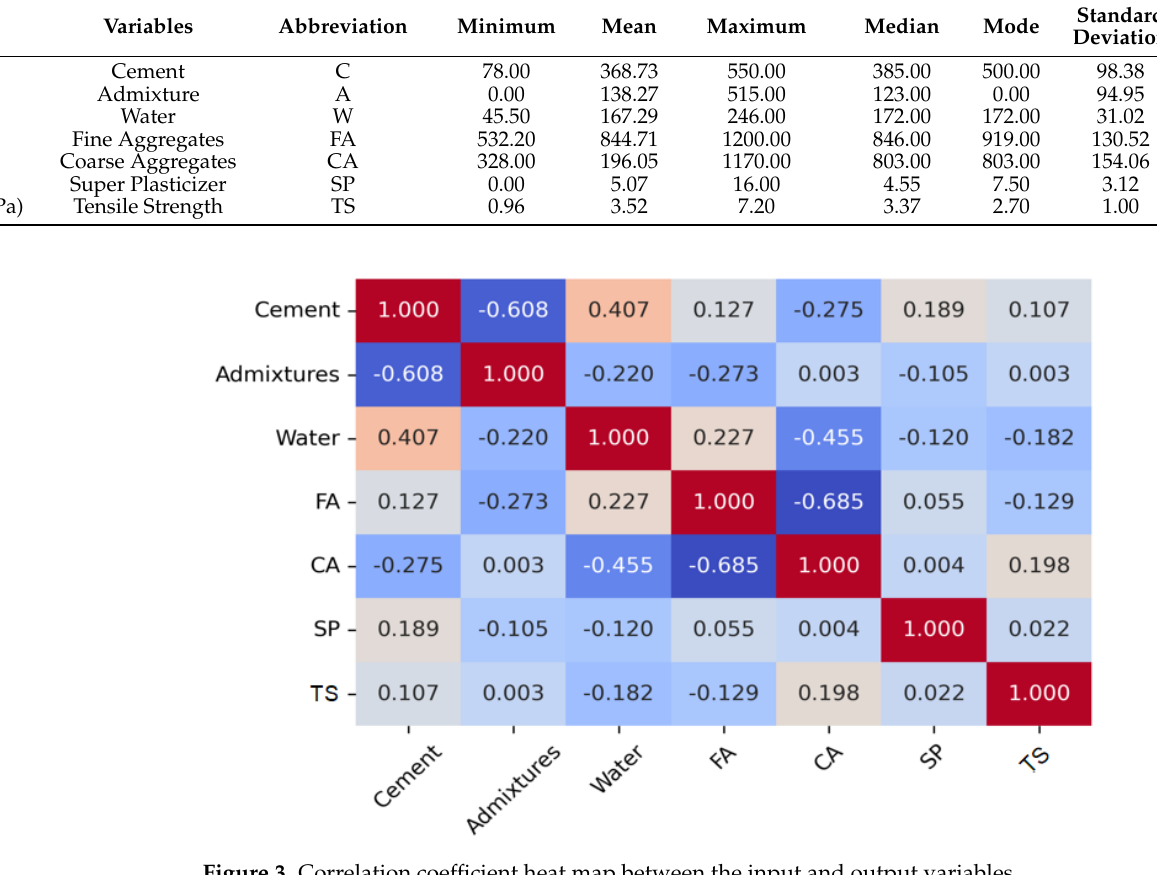
Figure 3. Correlation coefficient heat map between the input and output